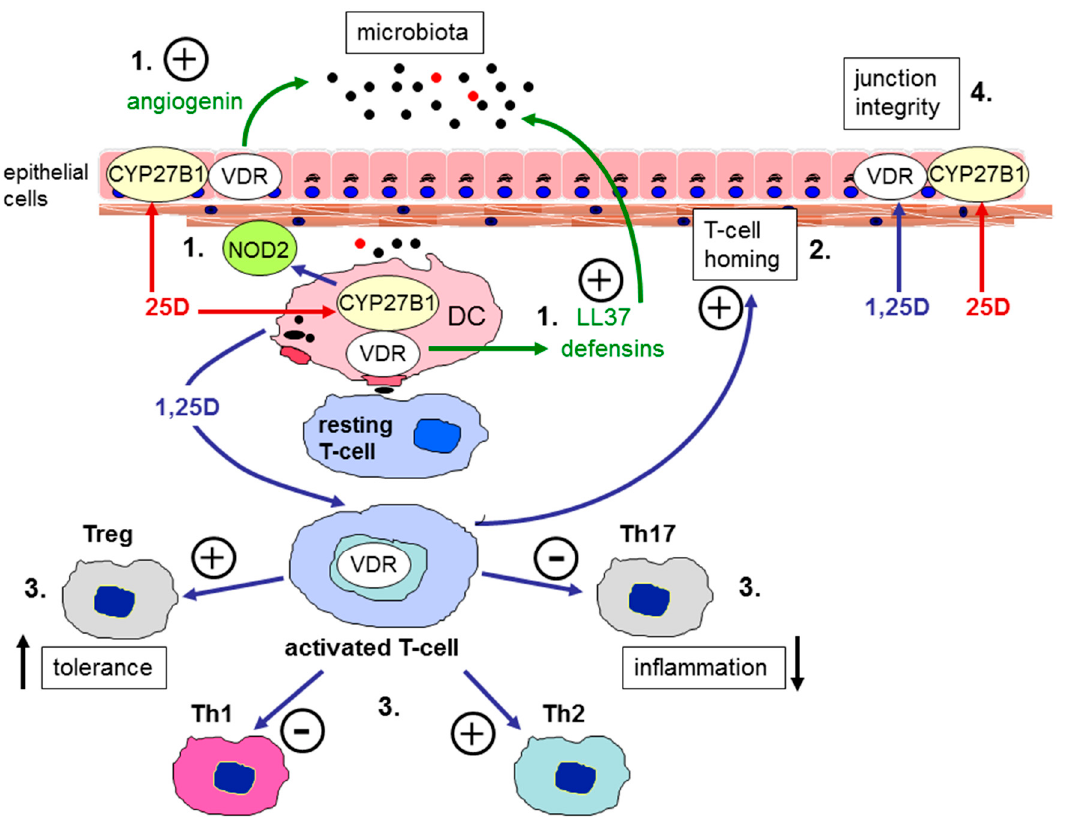
Figure 1. Vitamin D and barrier function in the gastrointestinal tract. Schematic representation of the expression of the vitamin D receptor (VDR) and vitamin D-activating enzyme (CYP27B1) in human colonic epithelial cells, antigen presenting cells such as dendritic cells (DC), and T cells. Immune responses to vitamin D occur either via systemic 1,25-dihydroxyvitamin D (1,25-(OH)2D) or local conversion of 25-hydroxyvitamin D (25-OH-D) to 1,25-(OH)2D. Possible target mechanisms include: 1) interface with microbiota (induction of antibacterials such as angiogenin, cathelcidin (LL37), defensins or intracellular pathogen recognition proteins such as nucleotide-binding oligomerisation domain containing 2 (NOD2)); 2) T cell homing to sites of inflammation; 3) suppression of inflammatory Th17 and Th1 cells and induction of tolerogenic Treg and Th2 cells; 4) enhanced expression of epithelial membrane junction